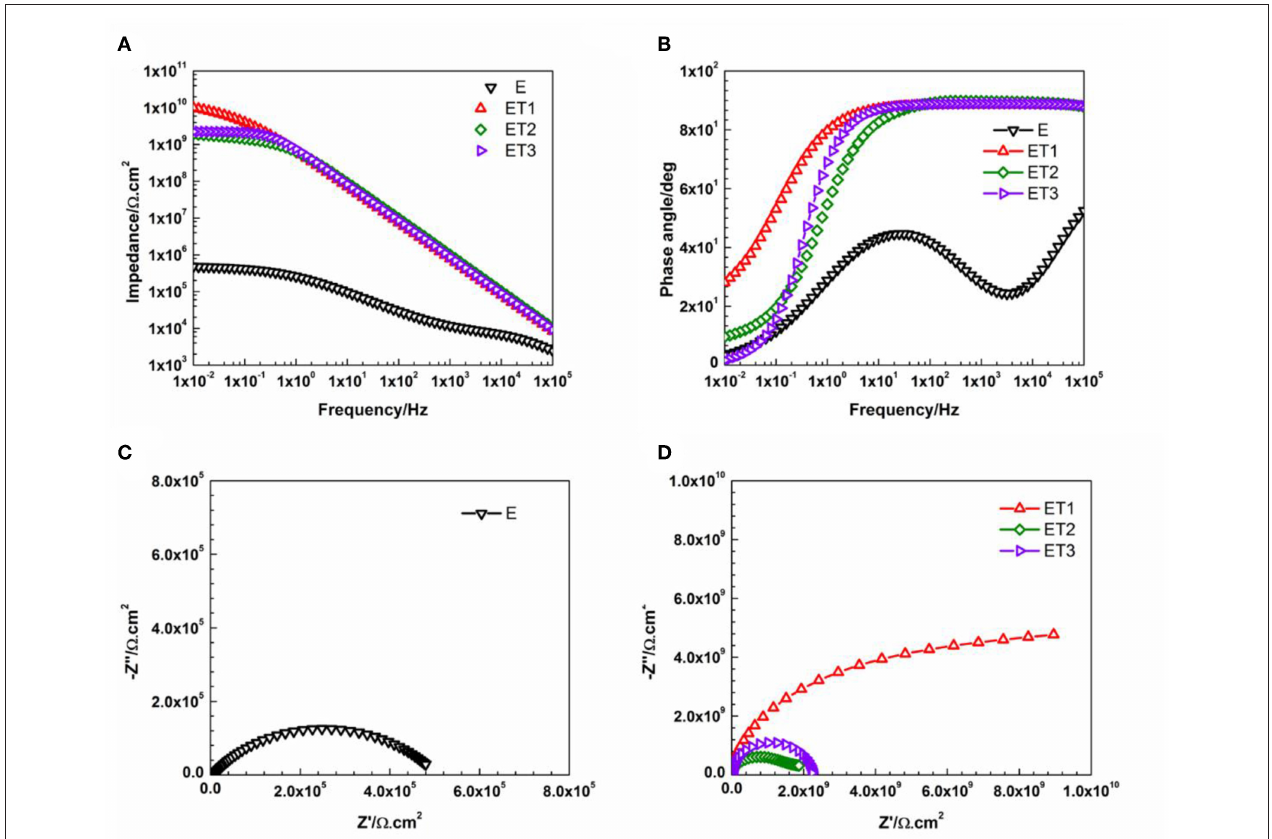
FIGURE 8 | Representative (A) Bode plots and (B) phase angle plots for all prepared epoxy-based coating systems, (C) Nyquist plot for E coating system, and (D) Nyquist plots for all epoxy-TiO 2 nanocomposite coating systems after 1 day of immersion.